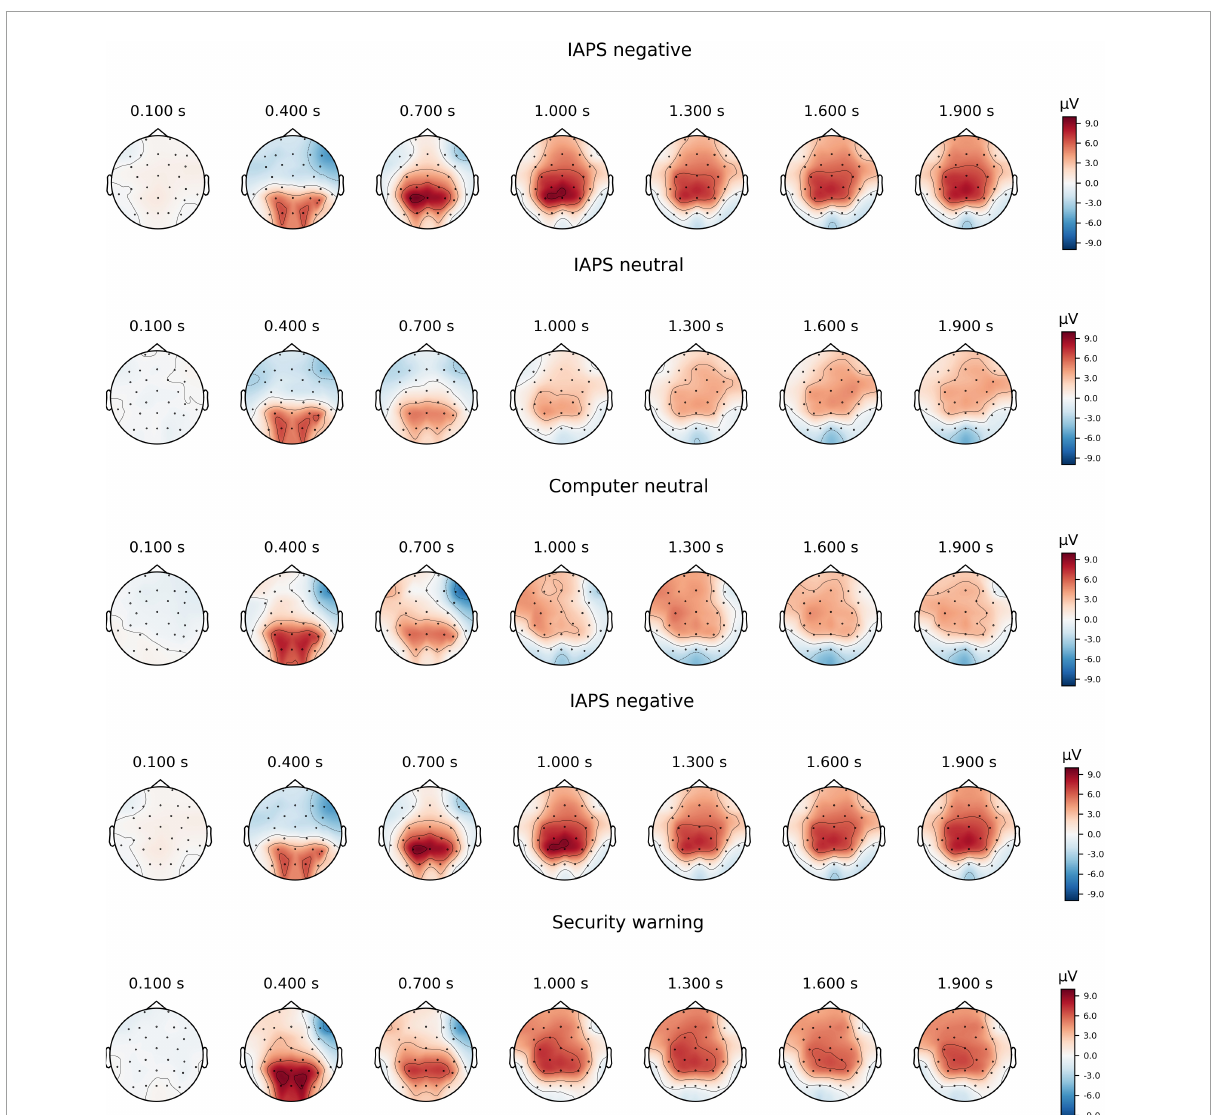
FIGURE1 Topographic maps of grand average amplitudes over time between 0 and 1,950 ms at 300 ms intervals for each of the five stimuli conditions.